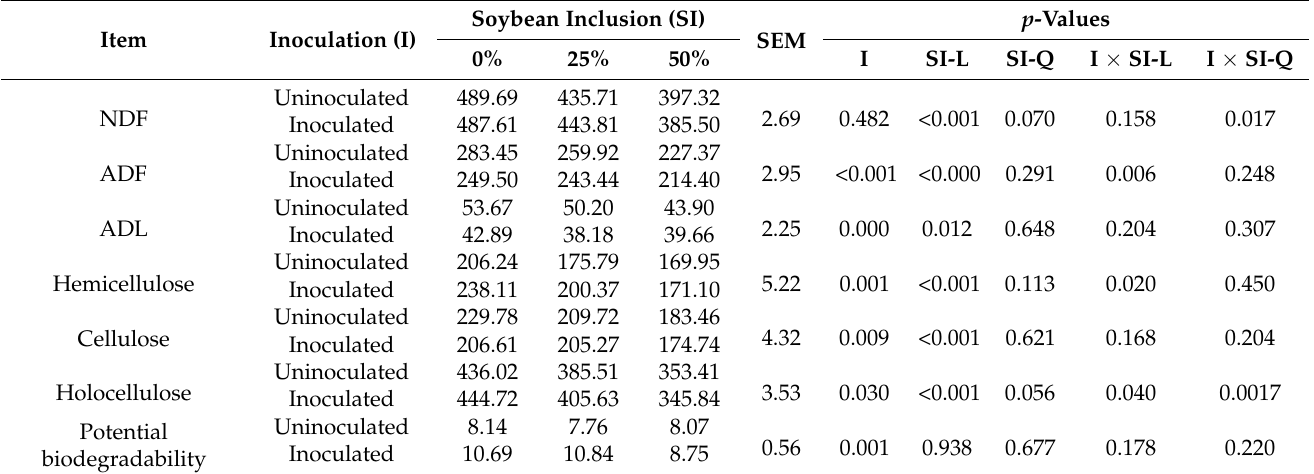
Table 5. Influence of soybean inclusion and L. plantarum A1 inoculation structural carbohydrates (g kg − 1 DM) and potential biodegradability of sorghum